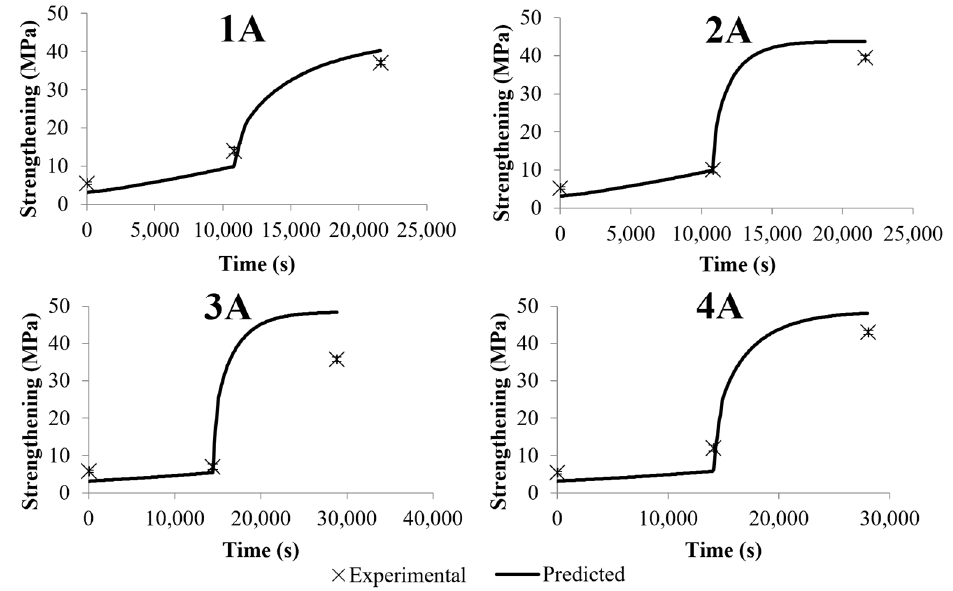
Figure 5. Graphs demonstrating the experimental and simulated results of several two ‐ step heat treatments for Al ‐ 0.04Sc at%, as described in Table 2. Error bars represent +/ − 2 standard error.